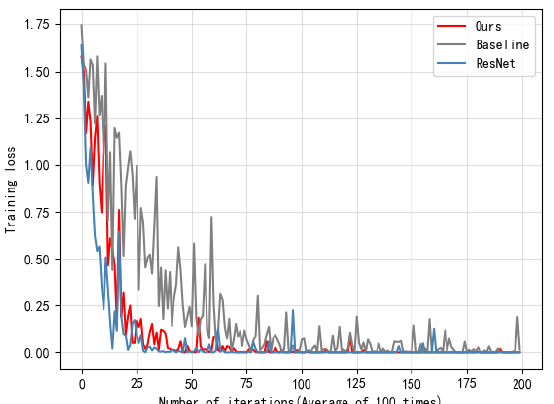
Figure 5. Loss visualization of different models on 5 ‐ way 1 ‐ shot.